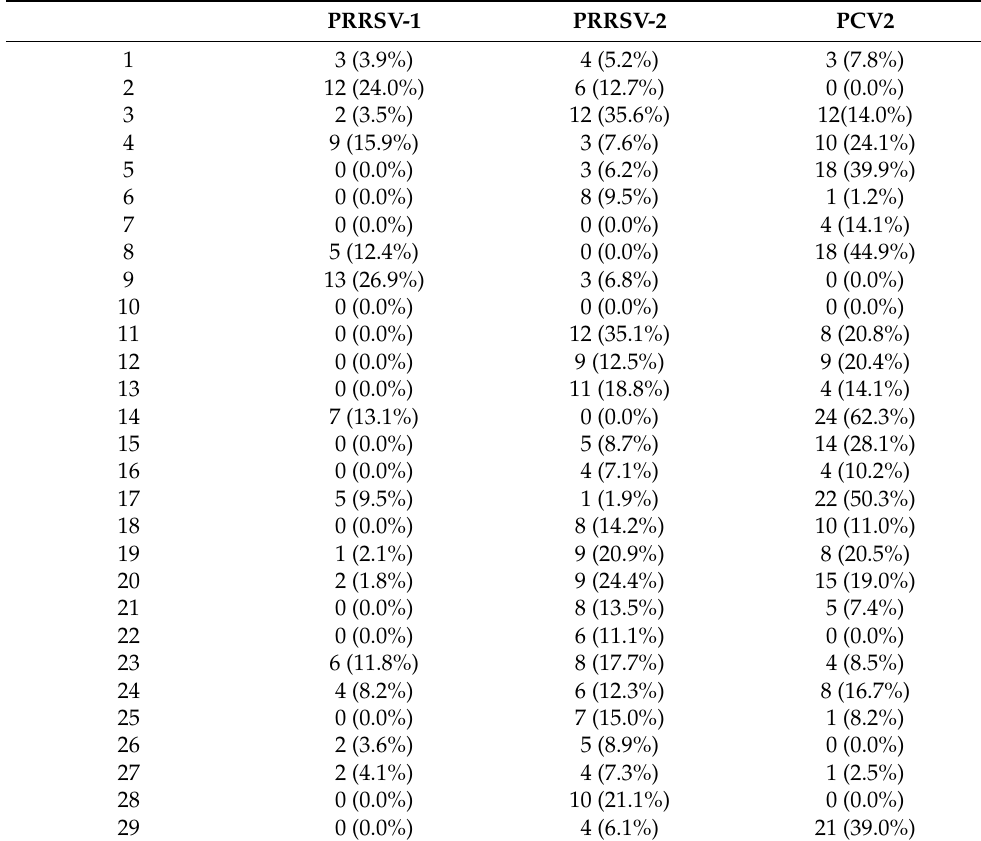
Figure 2. Estimated prevalences including 95%confidence intervals (the error bars) of porcine reproductive and respiratory syndrome virus European strain (PRRSV-1) and North American strain (PRRSV-2) and porcine circovirus type 2 (PCV2) for different age groups of pigs in the HKSAR farmed pig population.w4 = 4-week-old pigs; w8 = 8-week-old pigs; w12 = 12-week-old pigs; w16 = 16-week-old pigs; w20 = 20-week-old pigs; w24 = 24-week-old pigs; sow = breeding sows. Table 1. For 29 farms sampled in the HKSAR, of the 35 pigs sampled on each farm, the actual number of pigs that tested PCR positive for porcine reproductive and respiratory syndrome virus European strain (PRRSV-1) and North American strain (PRRSV-2) and porcine circovirus type 2 (PCV2) and the estimated prevalence (%) of each pathogen within each